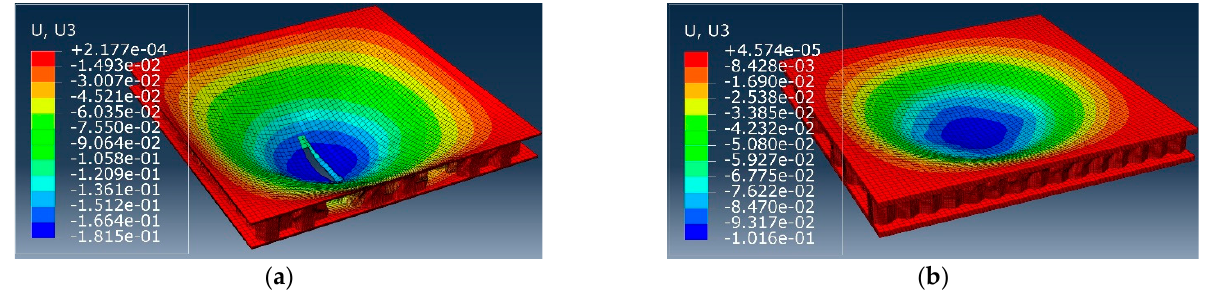
Figure 16. Honeycomb sandwich panel with D = 112.5 ( a ) P = 5 ( b ) P = 10.